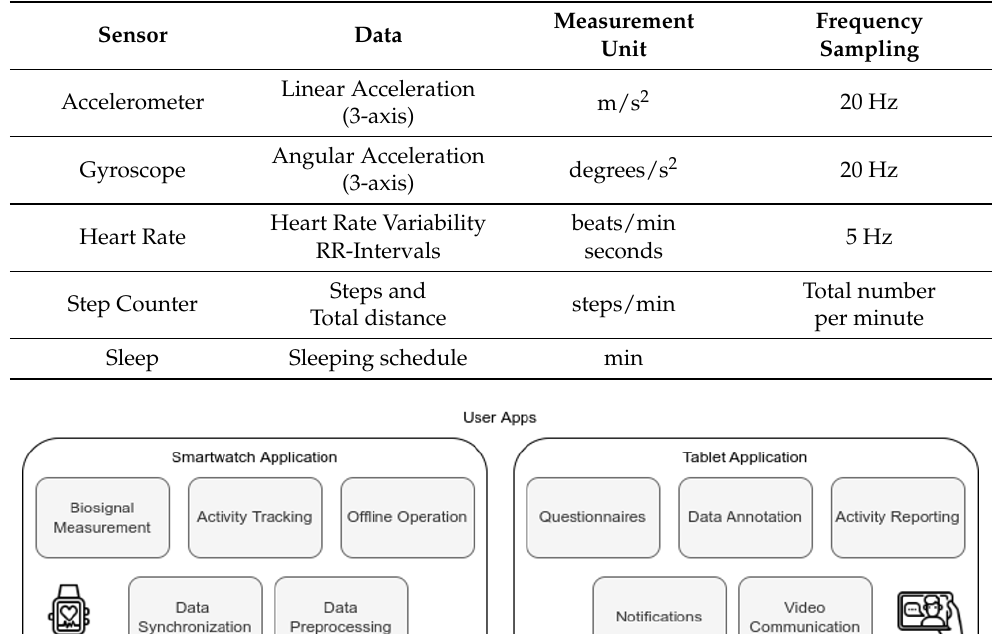
Table 1. Data collected from the smartwatch sensors.